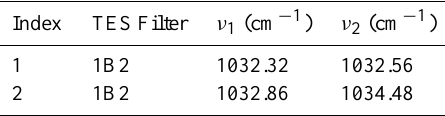
Table 2. Microwindows for TES CH 3 OH retrievals ∗ .